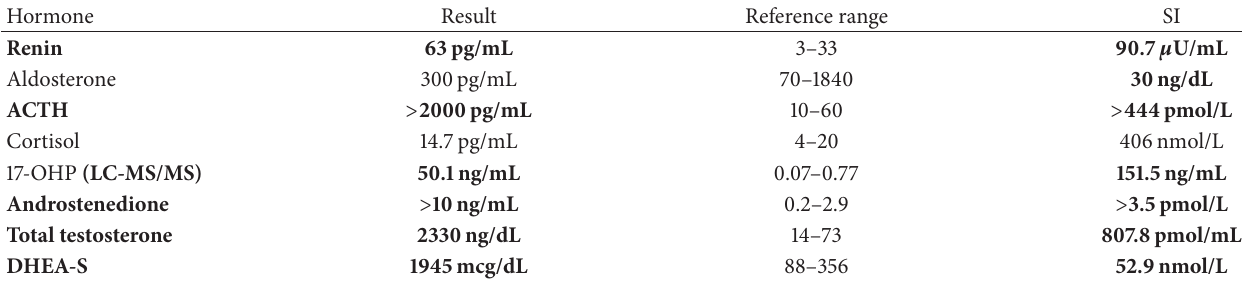
Table 1: Hormone profile of the patient before starting treatment.